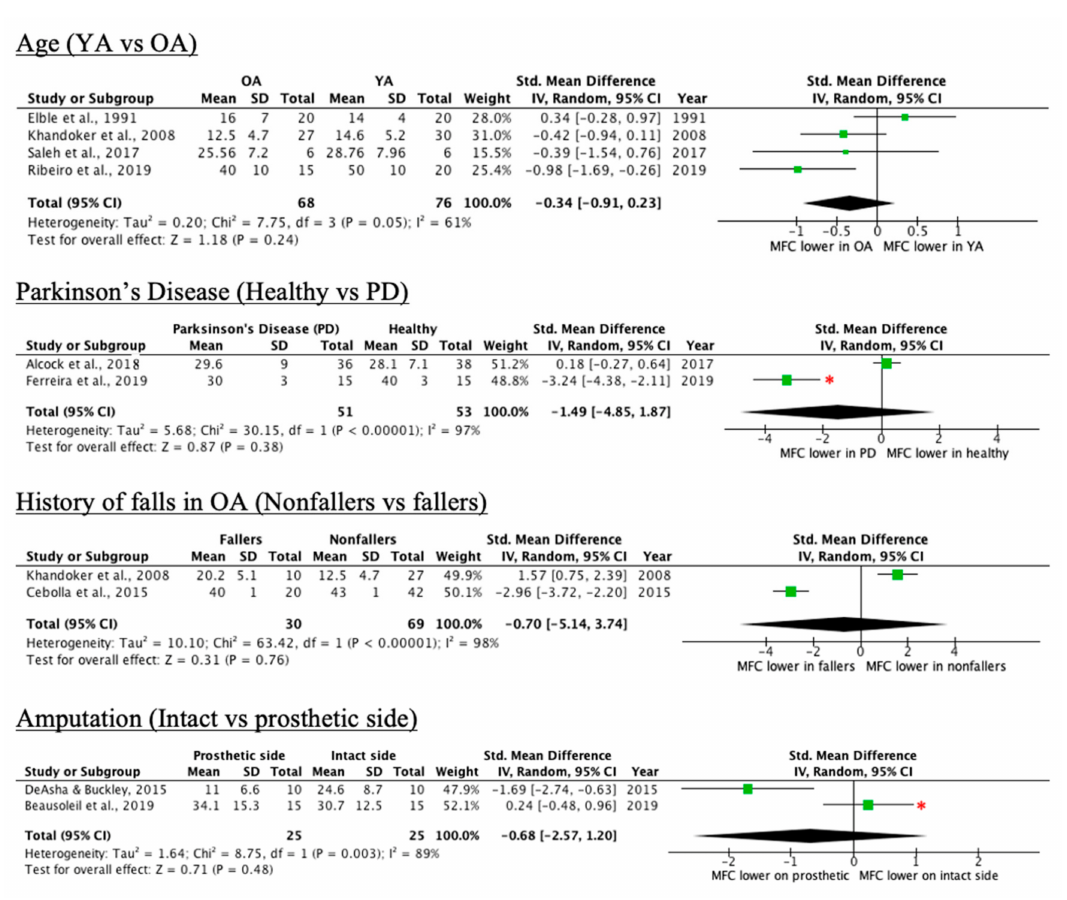
Figure 4. Forest plots of conditions comprising two or more studies without an overall MFC mean effect relative to control (* = original manuscript reports different finding; OA = older adults, YA = younger adults, PD = Parkinson’s